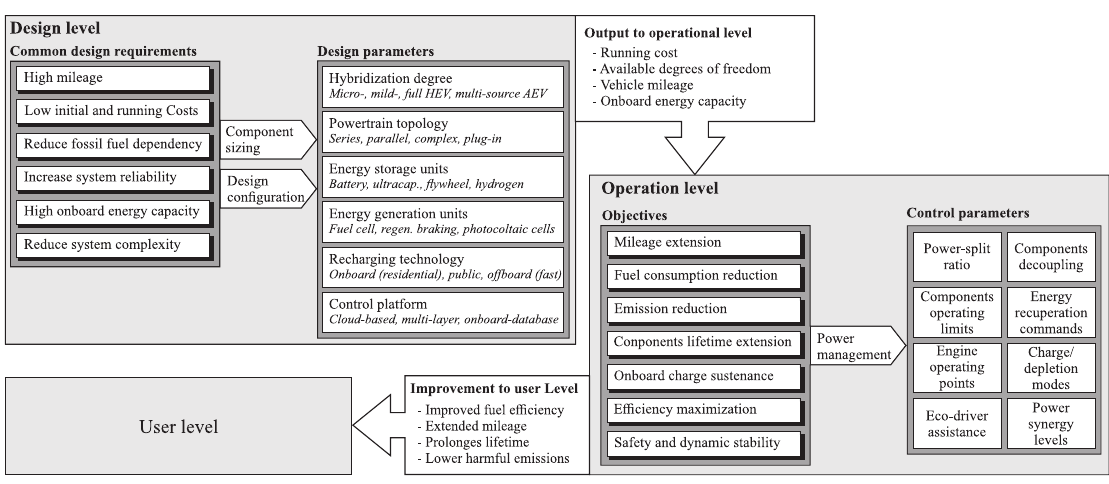
Figure 1. Design and operational objectives of hybrid electric